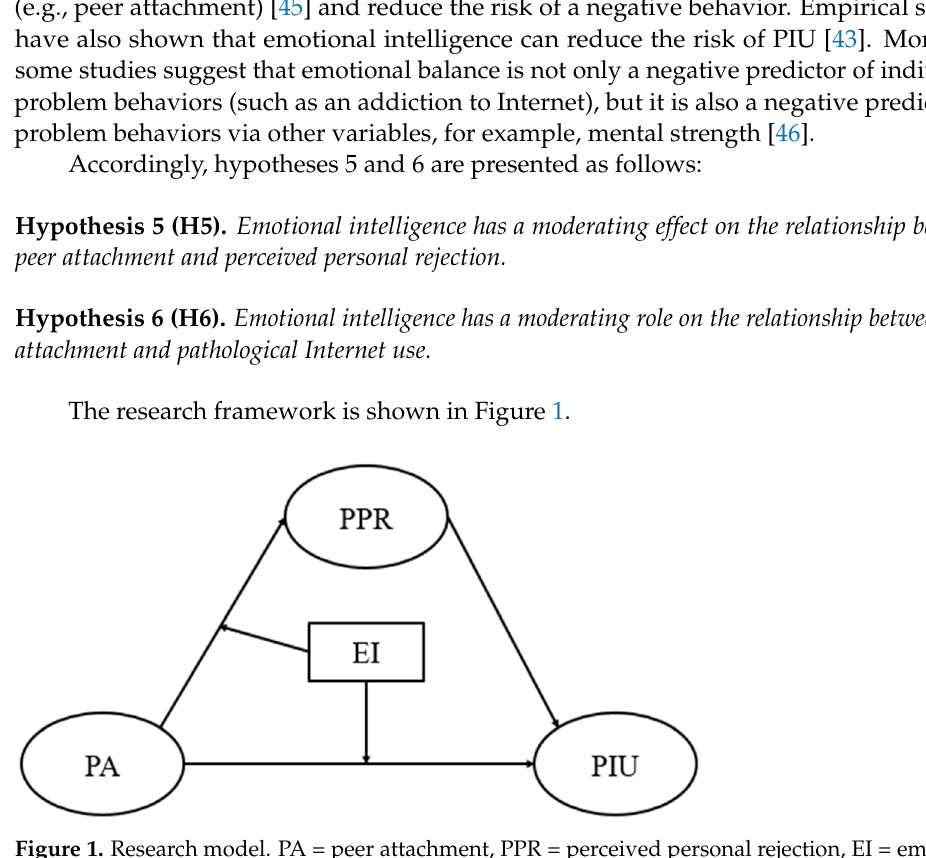
Figure 1. Research model. PA = peer attachment, PPR = perceived personal rejection, EI = emotional intelligence, PIU = pathological internet use.